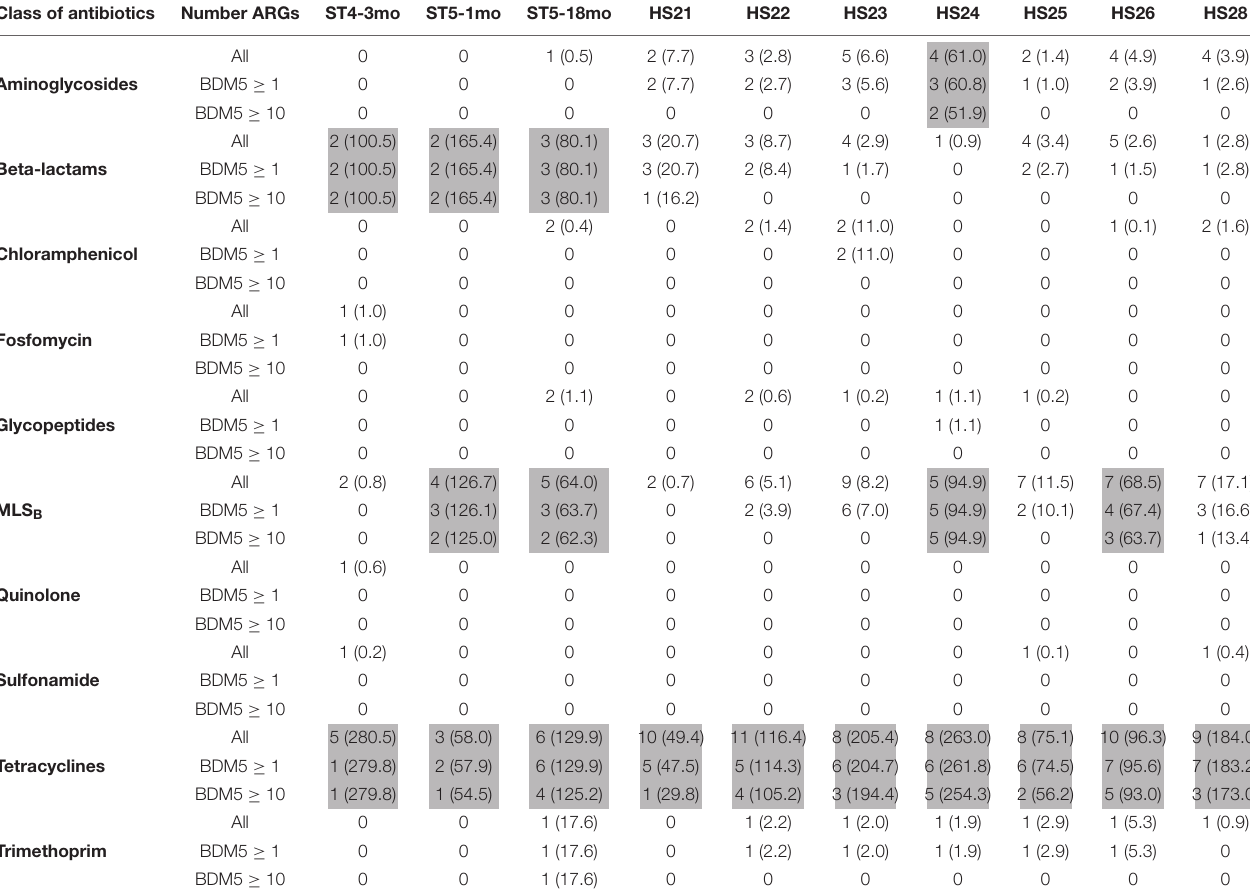
TABLE 1 | Number of antimicrobial resistance genes (ARGs) per class of antibiotics and per sample ( n = 13). Class of antibiotics Number